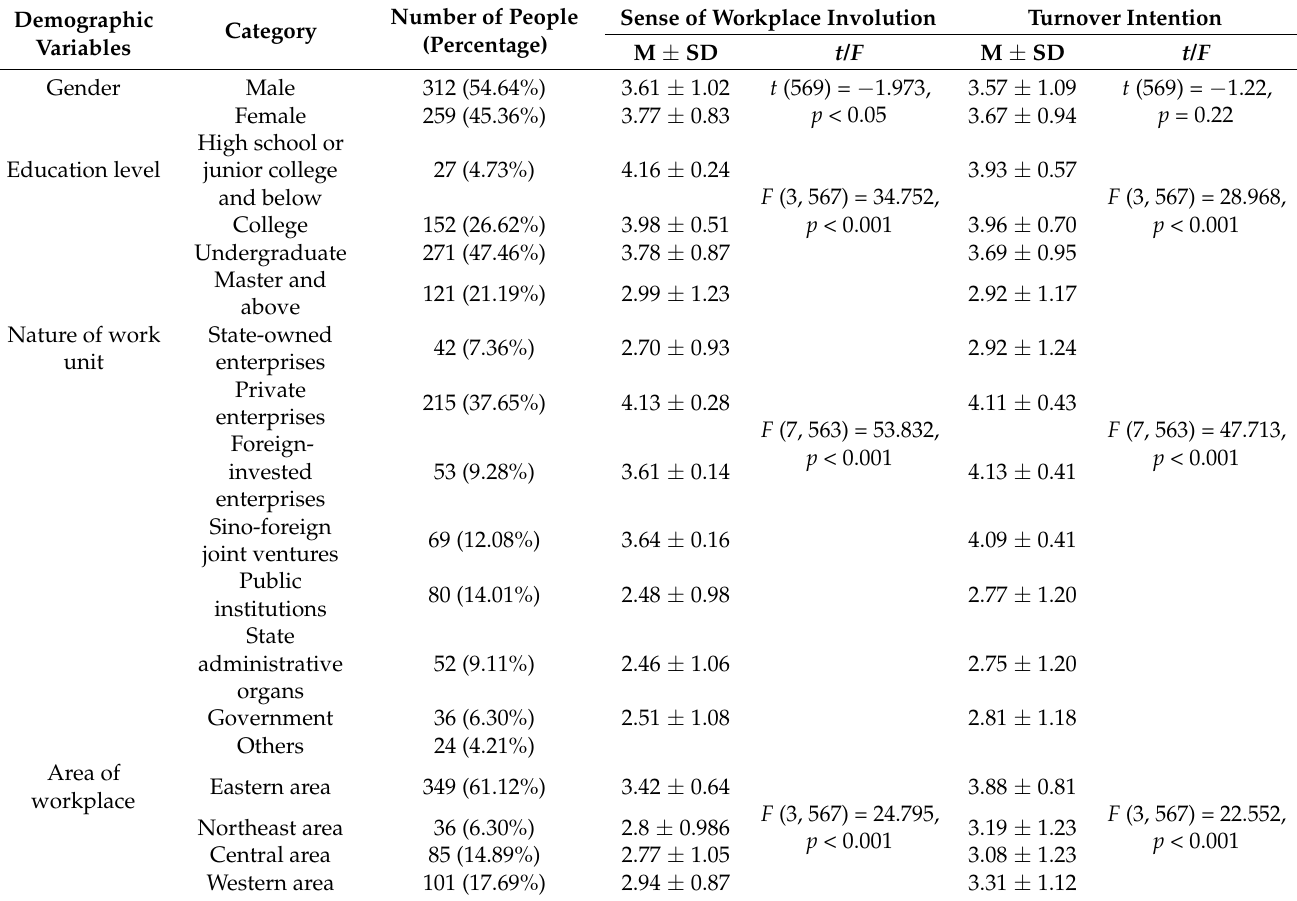
Table 6. Subjects’ demographic information and their t -tests and one-way analysis of variance.